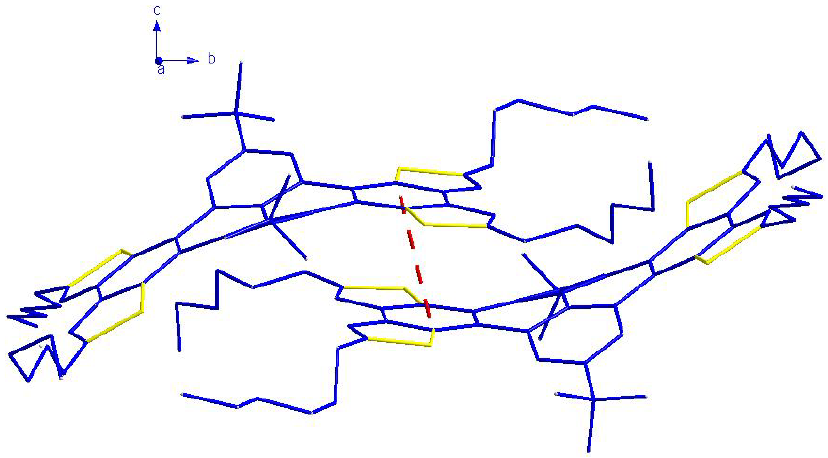
Figure 7. The π - π weak interactions between neighboring molecules (represented by red dashed lines).